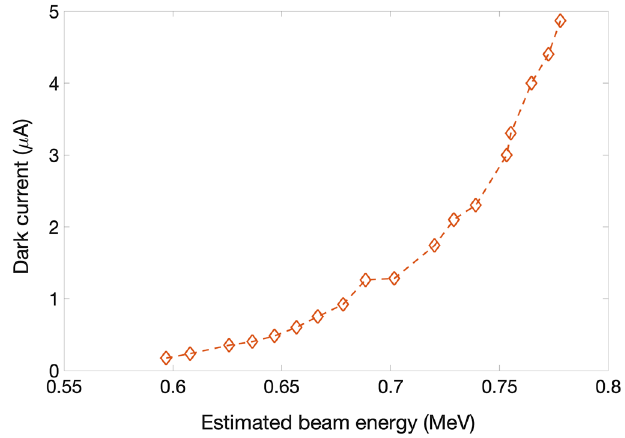
FIG. 13. Measured dark current versus beam